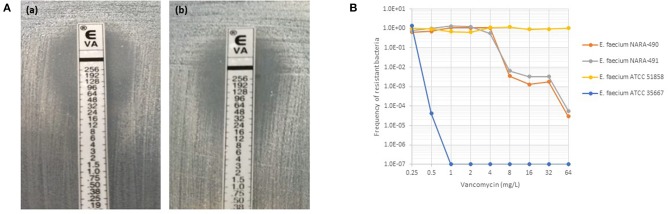
(A) Etest results for NARA-490 (a) and NARA-491 (b) strains with satellite colonies growing in the inhibition zone of vancomycin. (B) Vancomycin population analysis profiles for a fully susceptible (ATCC 35667), fully resistant (ATCC 51858), and heteroresistant strains (NARA-490 and NARA-491) to vancomycin.